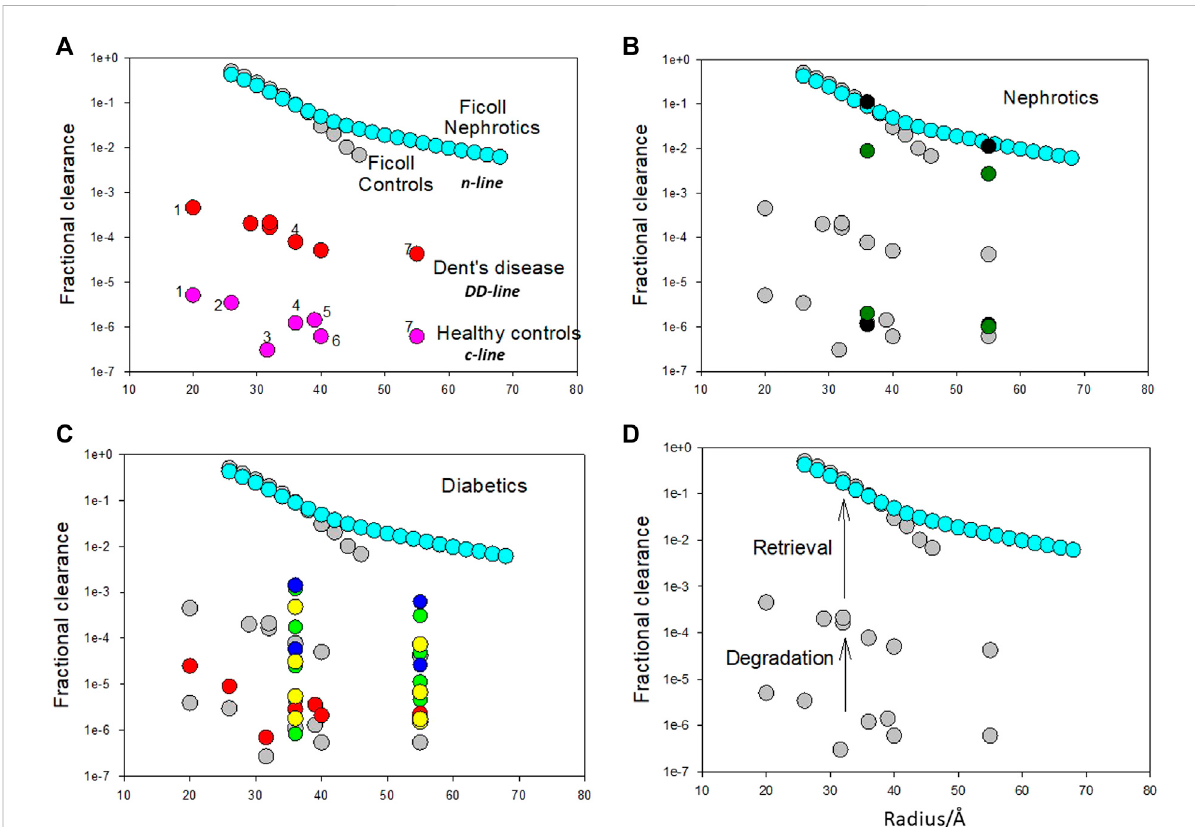
degradation pathway prior to excretion of the degradation products (Figure 1). Inhibition of the degradation pathway can be quite independent of the retrieval pathway (Russo et al., 2002; Comper et al., 2008). The biphasic processing is entirely consistent with the two albumin binding sites described by Park and Maack (Park and Maack, 1984; Russo et al., 2002; Comper et al., 2008) (Figure